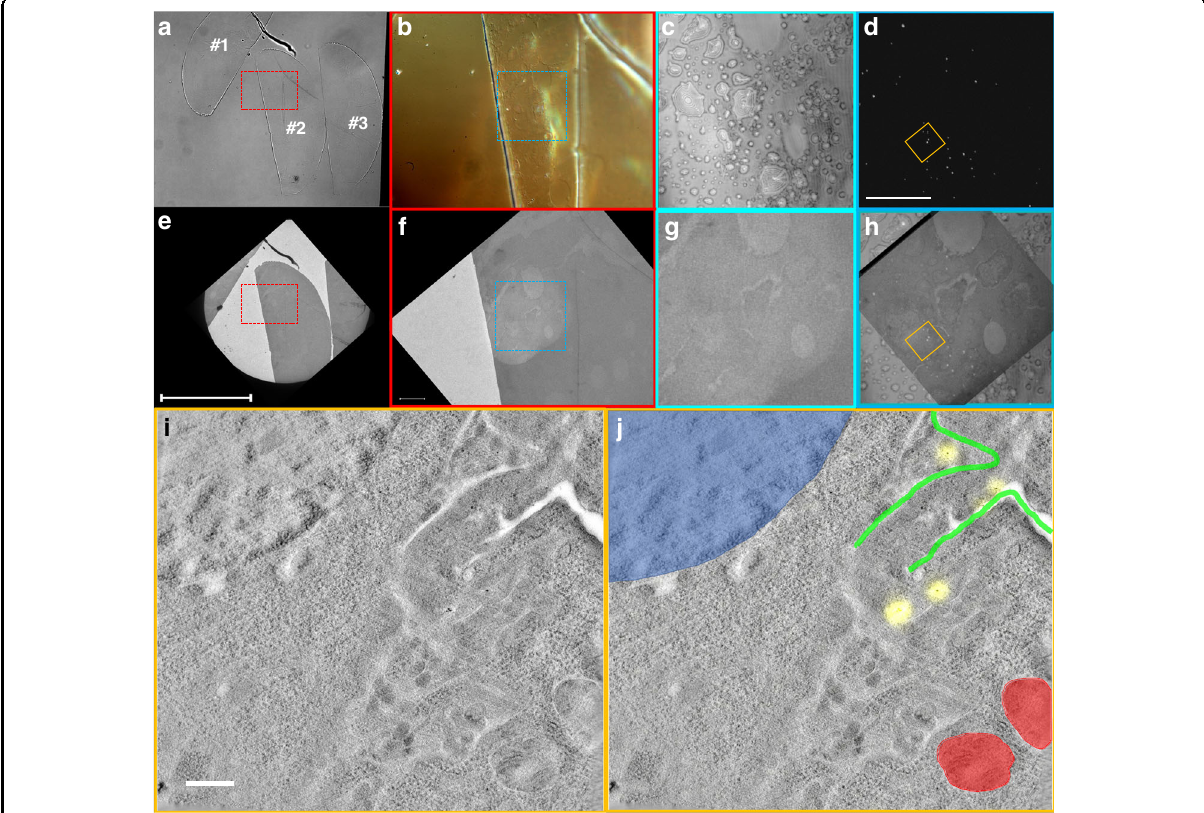
Fig. 7 FWM-CLEM work fl ow. Sections are fi rst visualised by bright- fi eld transmission and DIC microscopy, followed by simultaneous re fl ection and FWM imaging. Sections are then retrieved for TEM analysis, where the same cell regions are identi fi ed. a Bright- fi eld transmission microscopy overview image using white-light illumination (halogen tungsten lamp V2-A LL 100 W; Nikon) with a 0.72NA dry condenser, a 10 × 0.3 NA dry objective, and a monochrome CCD camera (Hamamatsu Orca-285). It shows three sections with some folds in section 2 and another imperfection at the top of section 2. b Higher magni fi cation DIC image (red boxed area from a), using white-light illumination, a 1.34 NA oil condenser, a 60 ×